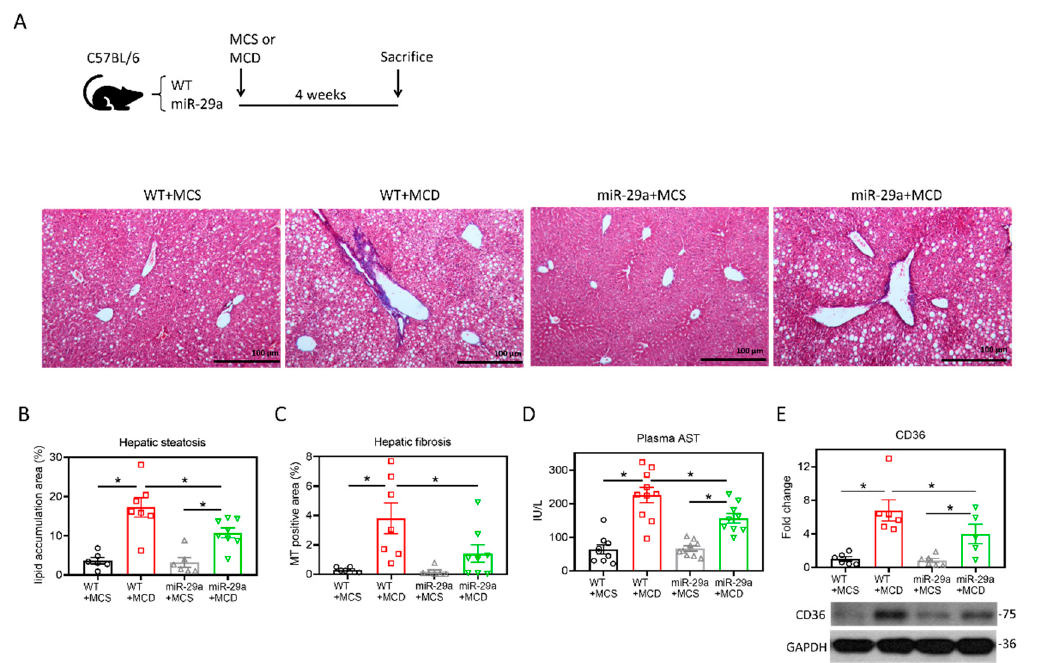
Figure 1. Overexpression of miR-29a attenuates MCD-induced hepatic steatosis and fibrosis. ( A ) Representative images of Masson’s trichrome stain. Vacuole formation and blue stain indicate hepatic lipid accumulation and collagen matrix accumulation, respectively. ( B and C ) Quantification of vacuole formation (hepatic steatosis) and blue stain (hepatic fibrosis). ( D ) Plasma aspartate aminotransferase (AST) level was determined with SPOTCHEM EZ automated biochemical analyzer. ( E ) Representative immunoblot result and densitometric quantification of CD36 protein expression. Data from five to ten samples per group are expressed as mean ± SE. * p < 0.05 between indicated groups. MCD, methionine/choline-deficient; MCS, methionine/choline-sufficient.